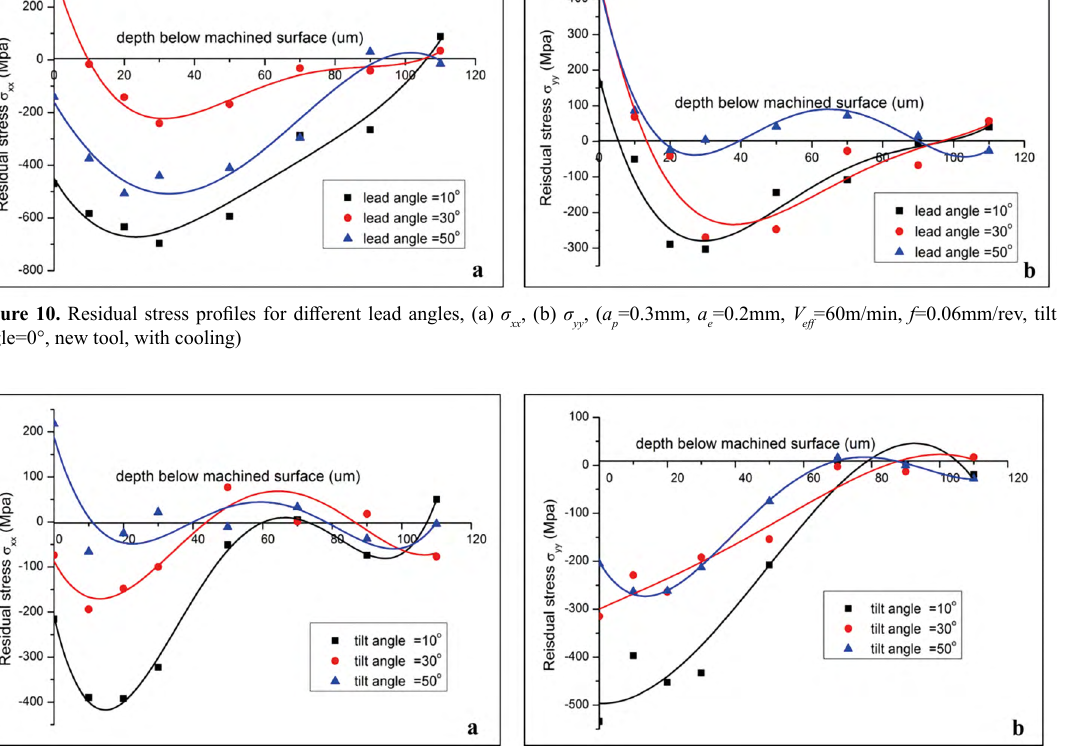
Figure 11. Residual stress profiles for different tilt angles, (a) σ angle=0°, new tool, with